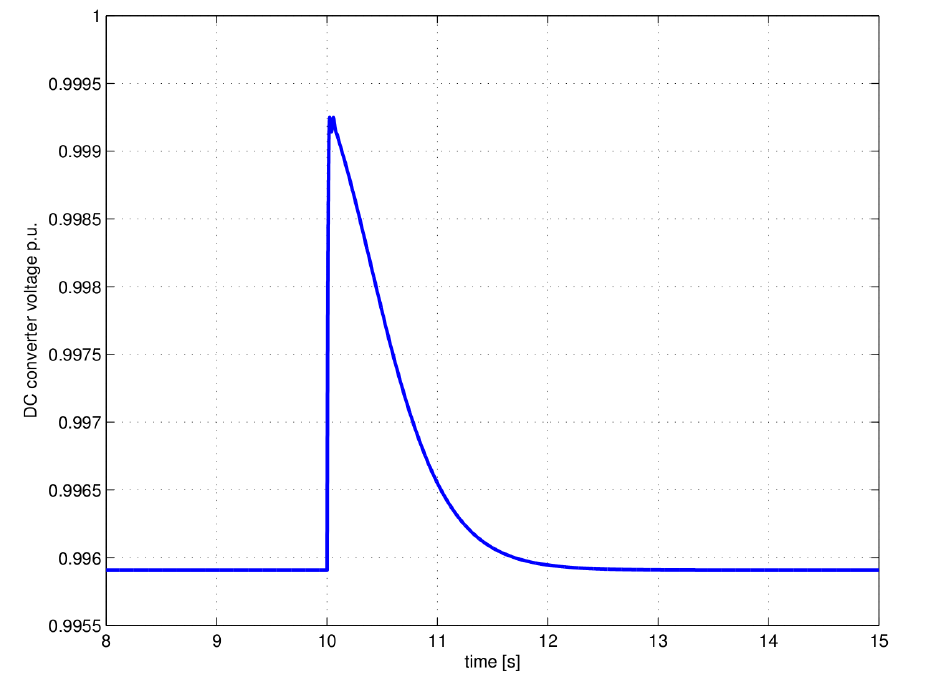
Figure 14. DC Link voltage transient due to the grid